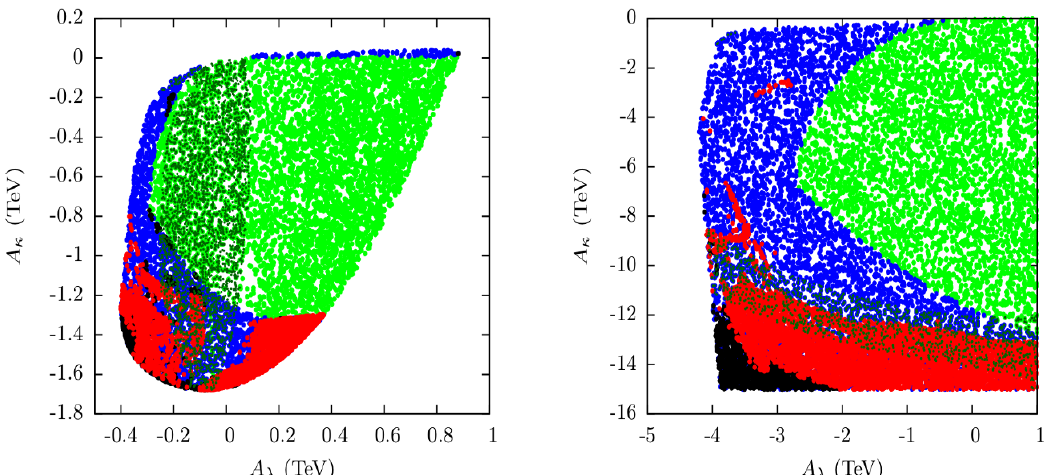
Figure 6 . Same as in (cid:12)gure 4 but in the in (cid:12)gures 4 except for (cid:22) e(cid:11) = (cid:0) A (cid:21) = 3 TeV and A t = m